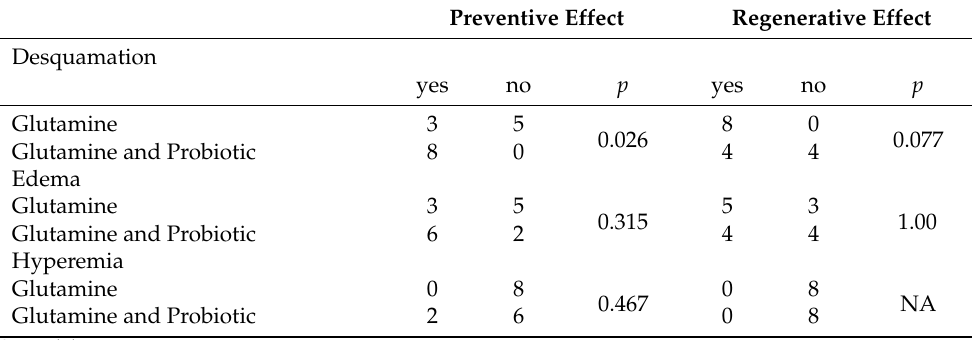
Table 1. Comparison between the preventive and regenerative effect according to the presence of desquamation, edema and hyperemia.